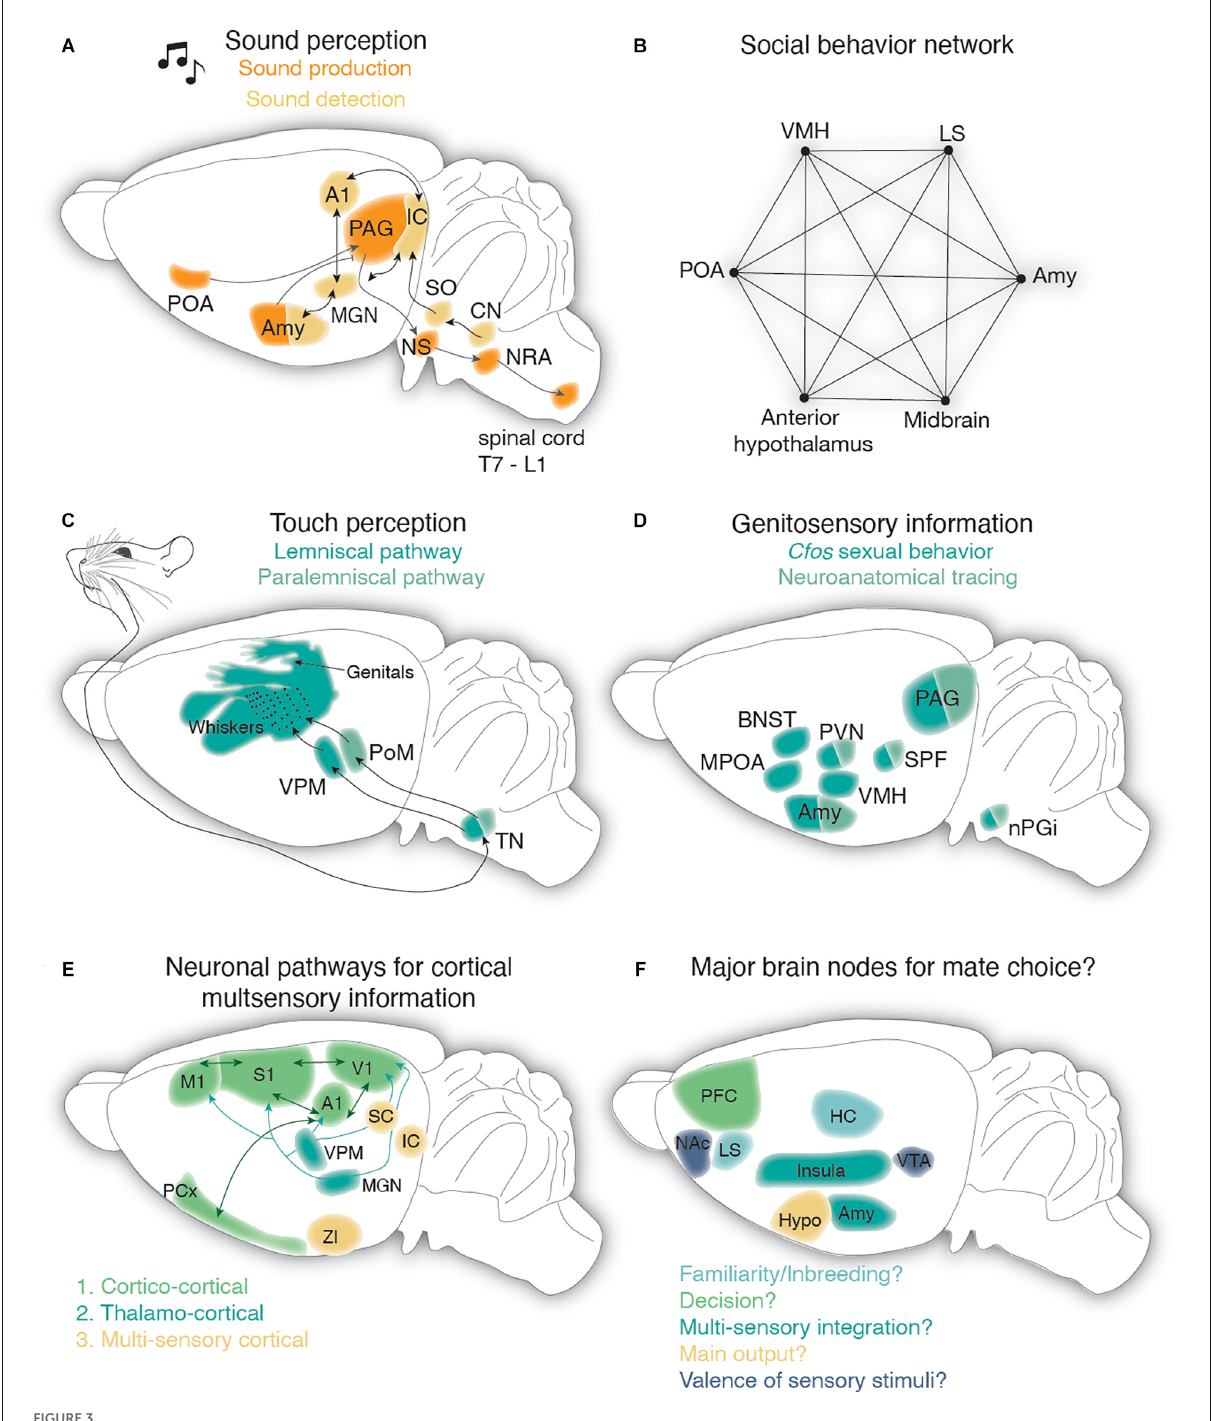
FIGURE3 Neural circuits for audition and somatosensation in the context of rodent mate choice. (A) Sound detection pathway is depicted in light yellow: auditory information from the cochlea is transmitted via the cochlear nerve to the cochlear nucleus (CN) which sends information to the superior olive from where it reaches the inferior colliculus. From the inferior colliculus, auditory information reaches the auditory cortex (A1) or amygdala (Amy) via the medial geniculate nucleus in the thalamus (MGN). IC and MGN are reciprocally connected with A1. Reciprocal connection between MGN and Amy has been observed as well. Sound production pathway is highlighted in orange: the periaqueductal gray (PAG) has been involved in mate choice produced USVs and receives auditory related feedback from the preoptic area (POA) and Amy. From the PAG information is sent to vocal pattern generators in the brain stem (nucleus solitarius, NS and nucleus retroambiguus, NRA) and from there is further processed in the